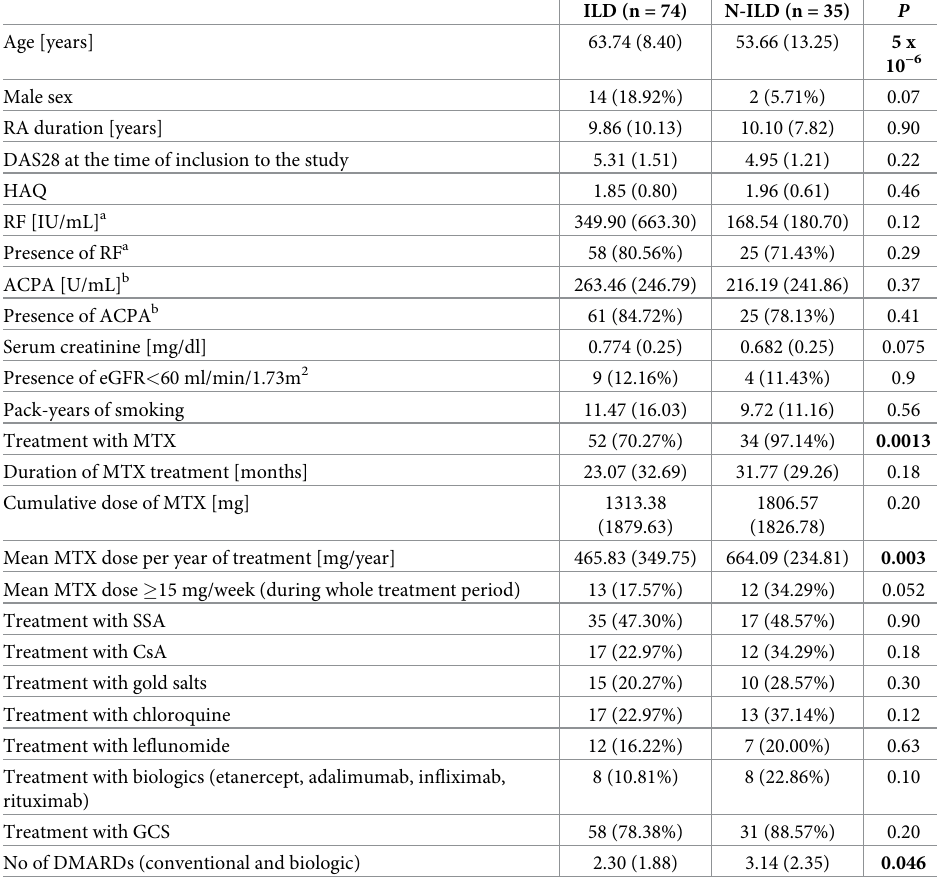
Table 3. Association of ILD with demographic and clinical characteristics of